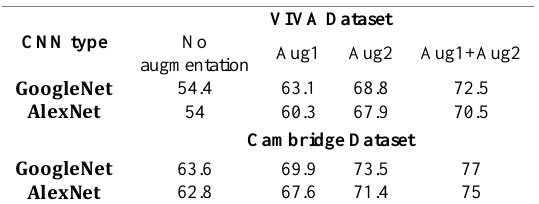
Table 5. Effect of data augmentation on classification accuracy. '-' Means that none of the data augmentation functions are applied. Aug1 includes frame reversing, translation, and rotation. Aug2 includes random crop, fixed-pattern drop, and random-pattern drop. ‘+’ means that both augmentations are applied simultaneously.